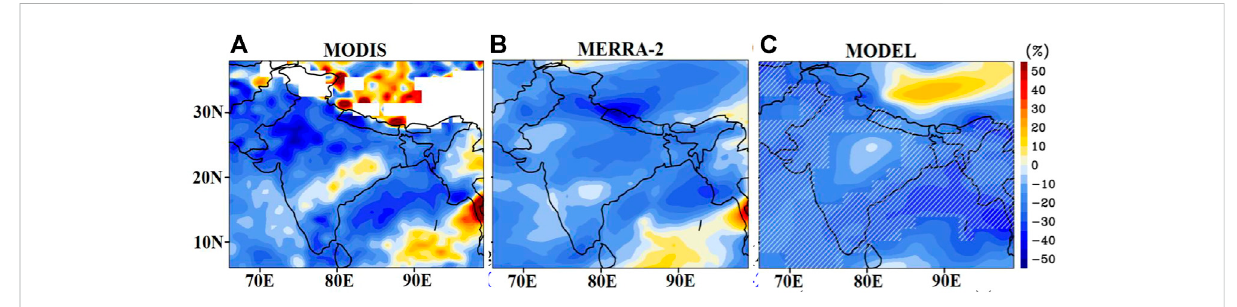
FIGURE 1 (A) Percentage change in aerosol optical depth (AOD) averaged for the lockdown period (mean of April-May 2020 - mean of April-May 2016 – 2019) calculated from (A) MODIS satellite observation, (B) MERRA-2 reanalysis, (C) ECHAM6-HAMMOZ simulated AOD anomalies (C19 — CTRL) averaged over 10 members. Hatching shows the area where mean differences between C19 and CTRL are statistically signi fi cant at a 95% con fi dence level.